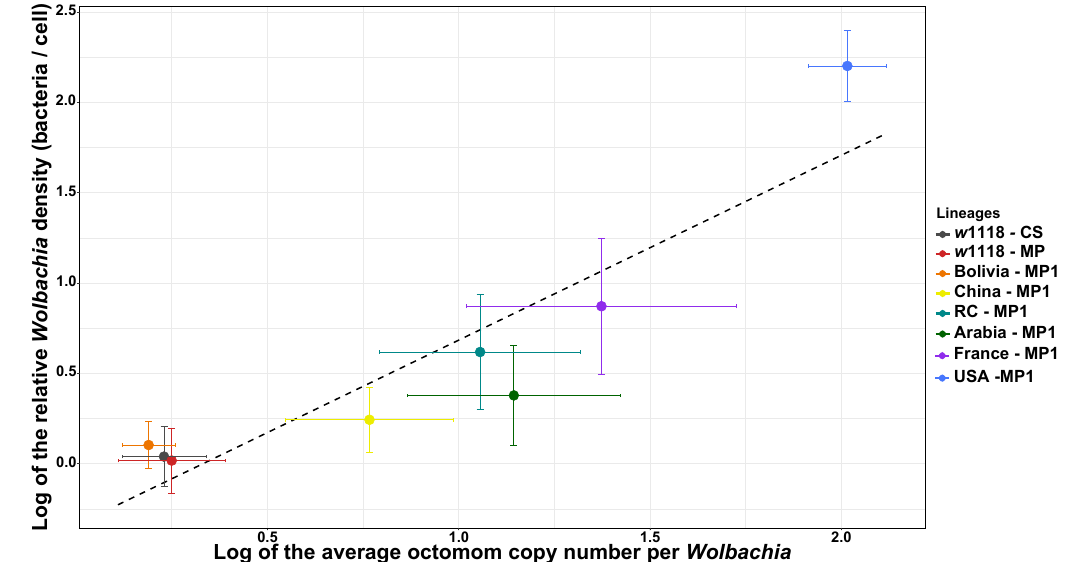
Figure 3: Relationship between the relative wMelPop density (log) and the average Octomom copy number per Wolbachia cell (log). Median ± SE. Each color represents a host genetic background (n = 10 flies / background), and the dashed line represents the linear